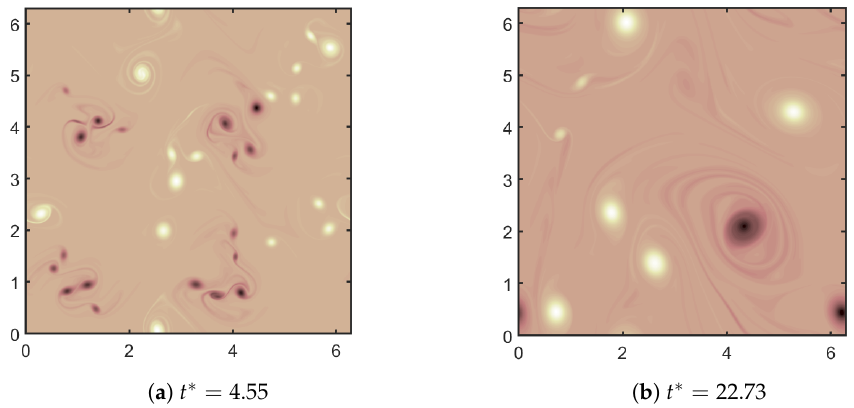
Figure 1. DNS vorticity at nondimensional times t ∗ (scaled by τ L